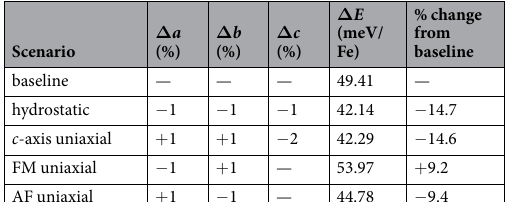
Table 1. Calculated ordering energies for several structural modifications of BaFe 2 As 2 parent, as could be produced via hypothetical lattice-parameter